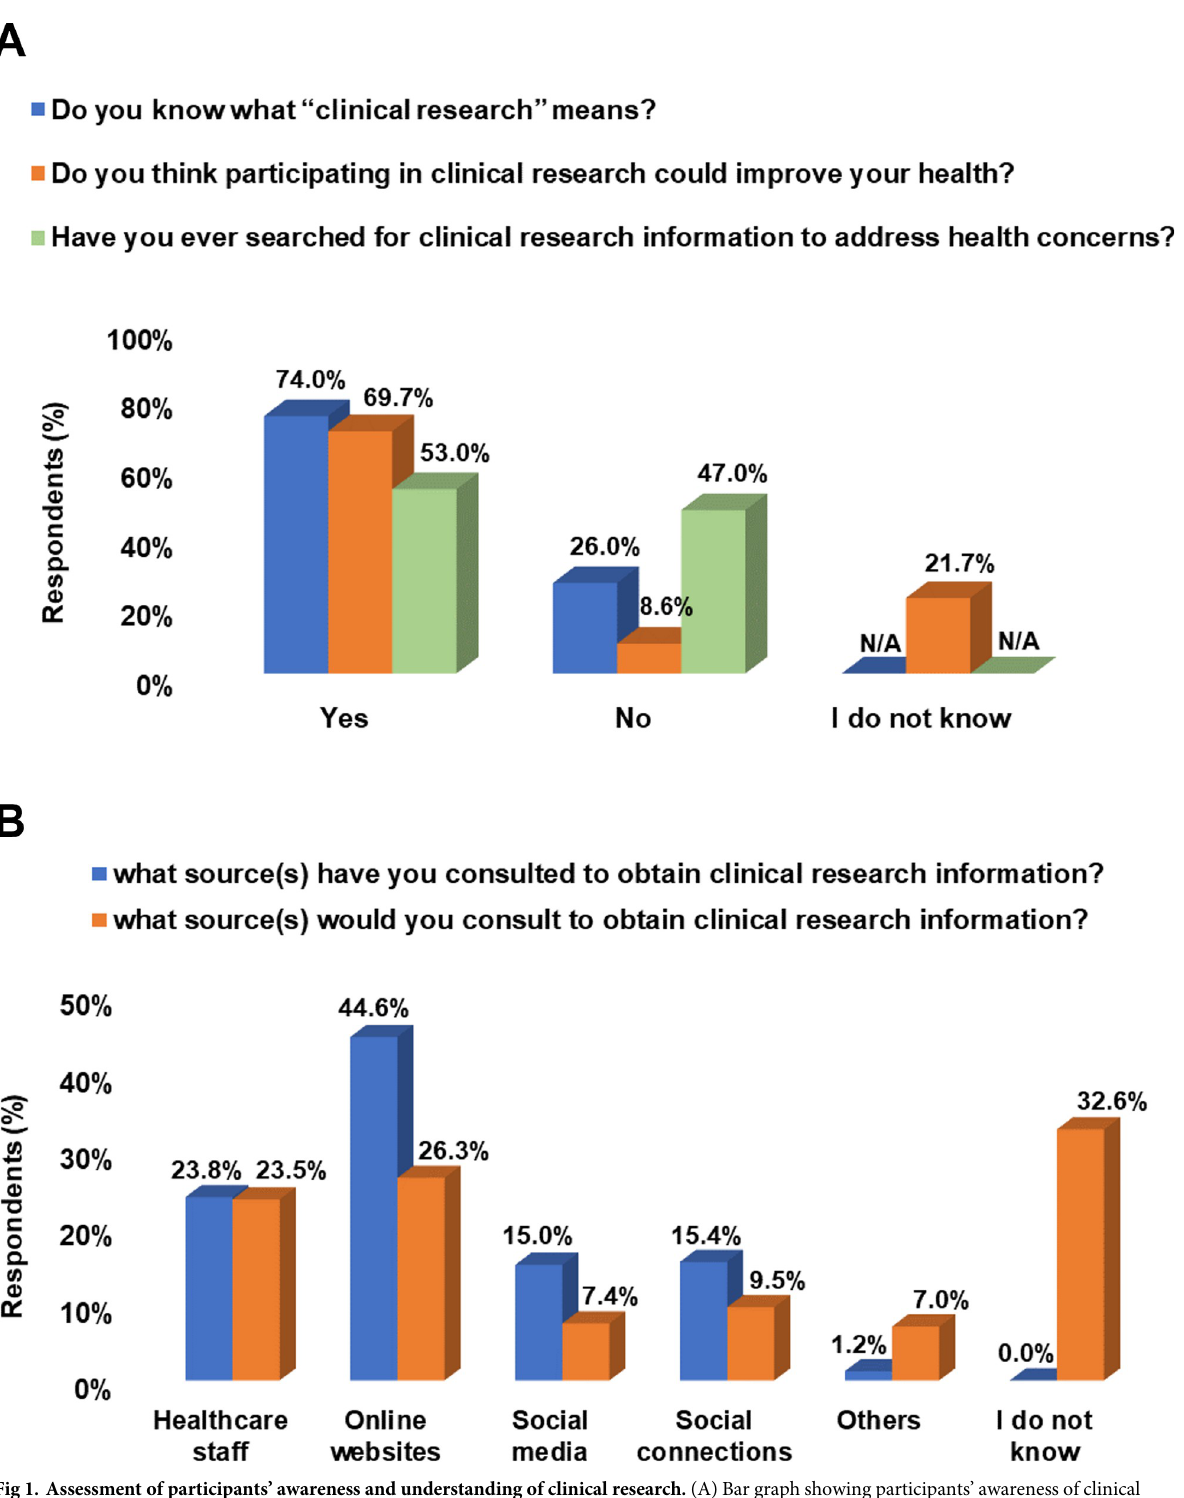
PLOS ONE | https://doi.org/10.1371/journal.pone.0270300 June 24, 2022 6 /